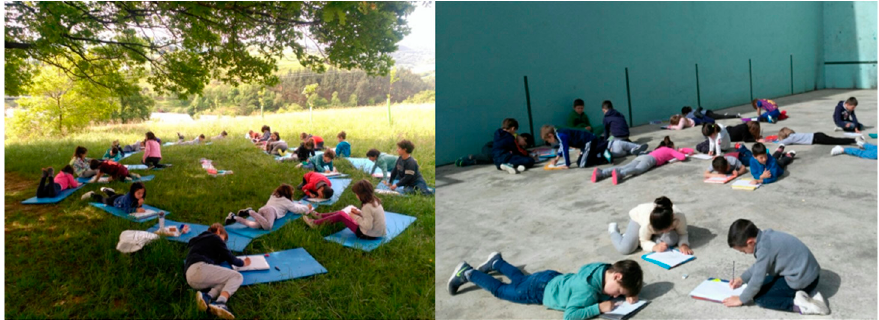
Figure 1. Participants in the green and grey spaces.